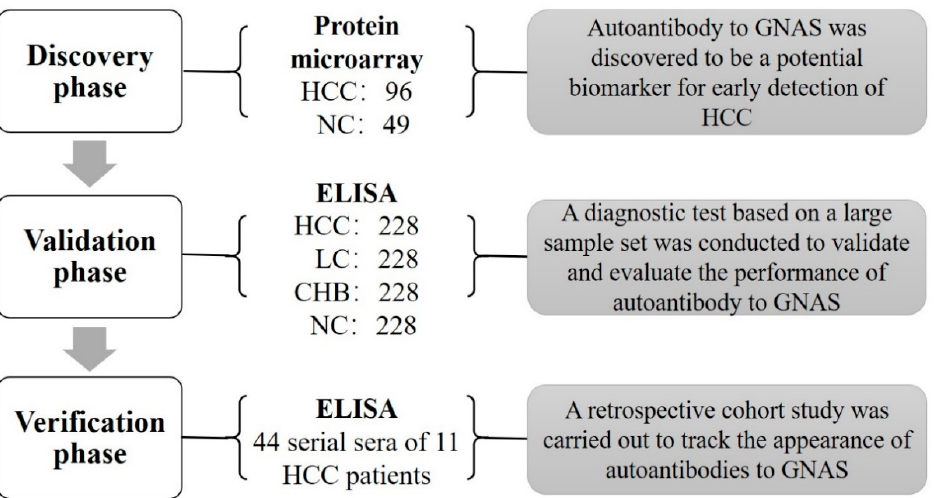
Figure 1. Flowchart of the study. A total of 145 subjects were first used to screen biomarkers in the discovery phase, autoantibody to GNAS was found to be a significant indicator for HCC. Subsequently, 912 participants in an independent set were included in the validation phase to validate and evaluate the performance of autoantibody to GNAS and finally, 44 serial serum samples of 11 HCC patients were used to track the appearance of autoantibody to GNAS. HCC: hepatocellular carcinoma; NC: normal control; LC: liver cirrhosis; CHB: chronic hepatitis B; ELISA: enzyme-linked immunosorbent